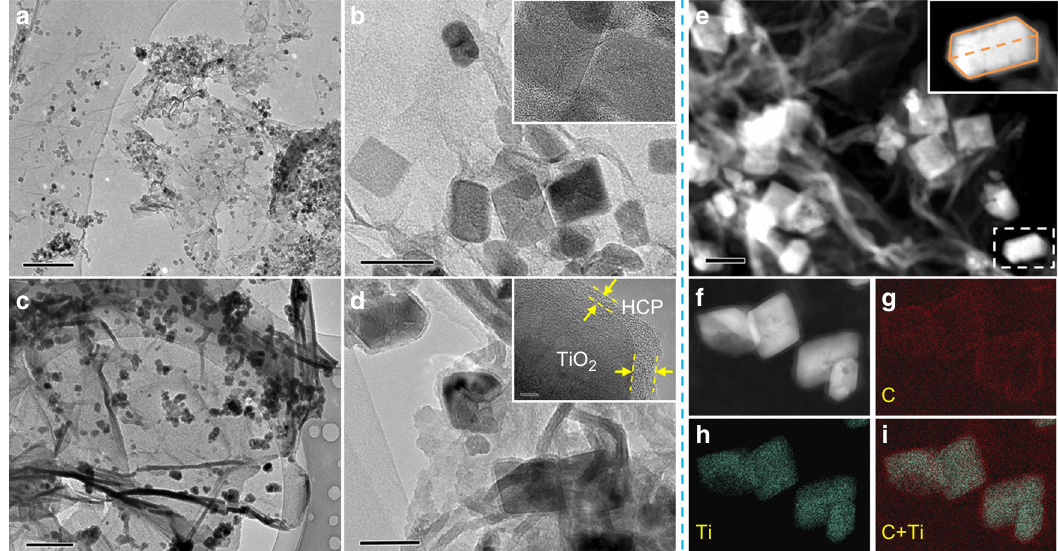
Fig. 2 Morphology and elemental mapping of various photocatalysts. TEM images of a , b TiO 2 -G and c, d HCP-TiO 2 -FG at different magni fi cation. The insets in b and d are the corresponding HR-TEM images. e STEM image of HCP-TiO 2 -FG. f – i High-angle annular dark fi eld (HAADF) mapping images of HCP-TiO 2 -FG. The scale bar are 200 nm in a , 50 nm in b , 0.5 μ m in c , 100 nm in d , 100 nm in e , and 5 nm in insets in b and d